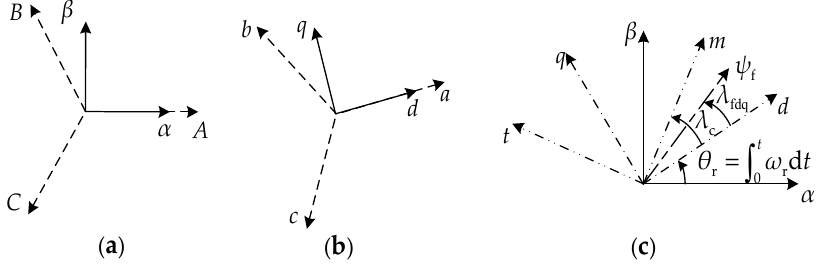
Figure 2. The relationship between the reference frames. ( a ) The relationship between the static stator three-phase reference frame and the static stator two-phase reference frame; ( b ) the relationship between the rotor three-phase reference frame and the rotor dq reference frame; ( c ) the relationship between the rotor dq reference frame and the synchronous mt reference frame.